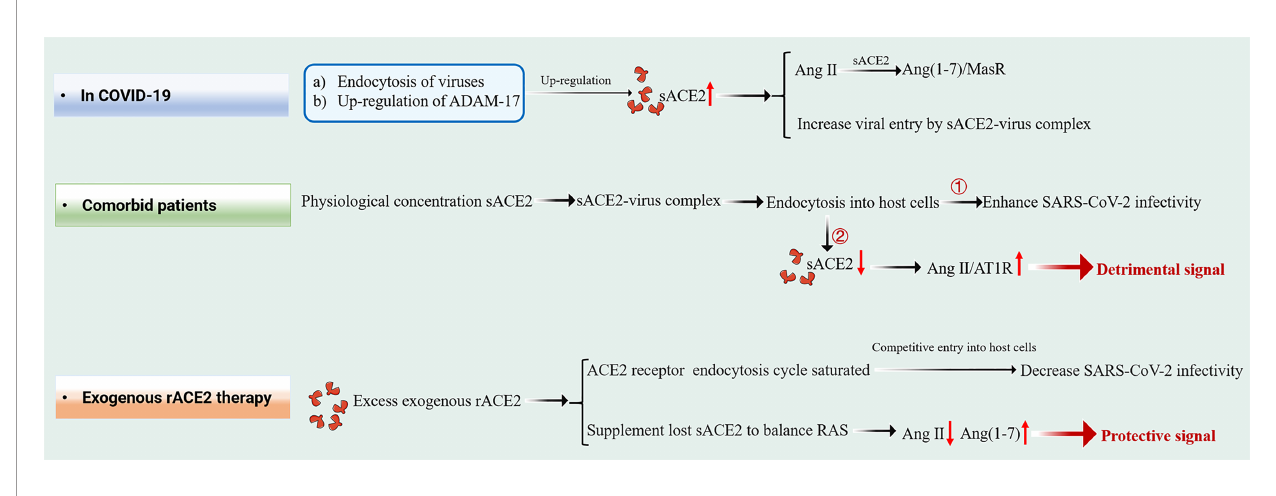
FIGURE 2 | Schematic diagram of the effect of sACE2 in circulation under three